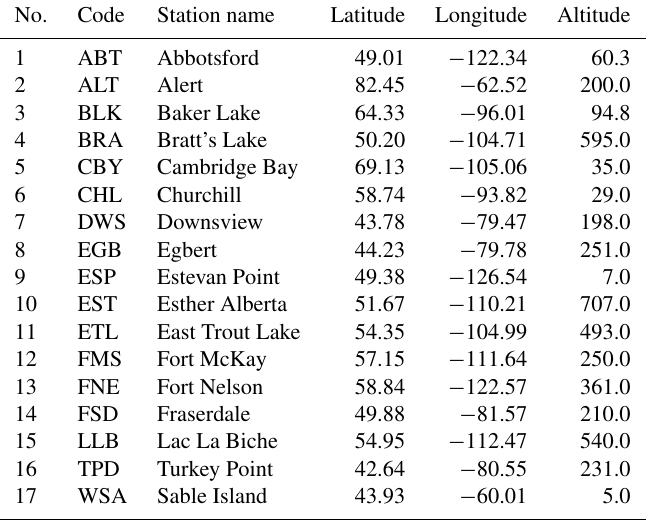
Table A1. Information about ECCC surface sites used in this study. The altitude is given in meters above sea level.